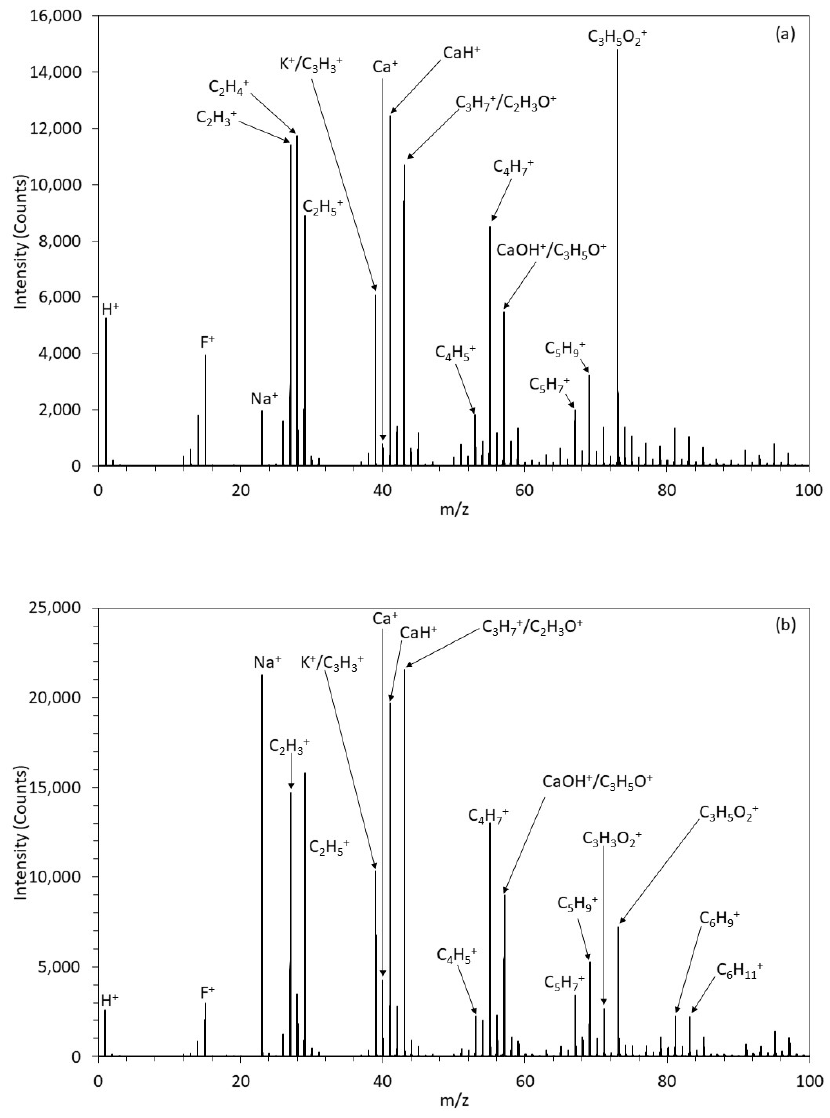
Figure 8. ( a ) ToFSIMS spectrum for 0HA. ( b ) ToFSIMS spectrum for 30HA.